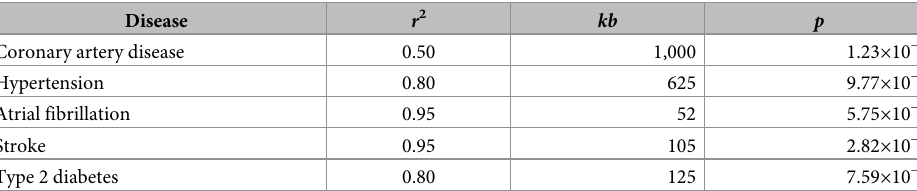
Table 5. Optimal hyperparameters for